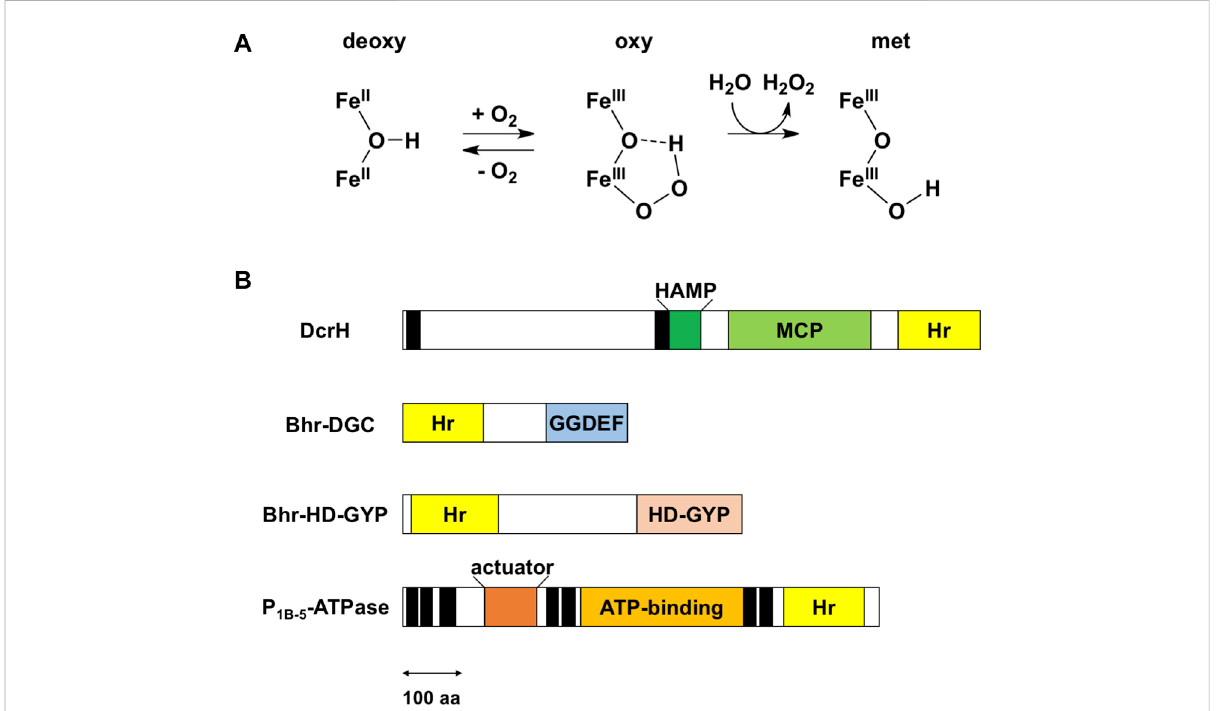
FIGURE 1 Reaction of the non-heme diiron center and domain structure of bacterial hemerythrin domain-containing sensors. (A) Reaction scheme for thenon-heme diiron center. Upper and lower ironsare Fe1 and Fe2, respectively. The iron ligand residuesare omitted for thesake of clarity. The oxy form is a transient intermediate in reactions involving bacterial hemerythrin domain-containing sensors. (B) Domain structures of bacterial hemerythrin domain-containing sensors that have been characterized so far, namely D. vulgaris DcrH (UniProt ID: Q726F3), V. cholerae Bhr- DGC(UniProtID:Q9KSP0), Ferrovum sp.PN-J185Bhr-HD-GYP(UniProtID:A0A149VUS3),and A.cellulolyticus P 1B-5 -ATPase(UniProtID:A0LQU2).